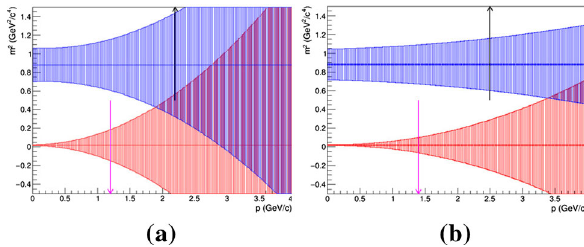
Fig. 2 m 2 distribution vs. particle momentum, measured by the CEE iTOF ( a ) and eTOF ( b ). In both plots, the red and blue areas identify bandswithin2 σ ofthe m 2 distributionofpionsandprotonsasafunction of momenta. The pink arrow marks the upper momentum under which 99.5% of the pions reside. The black arrow has a similar meaning, but for the protons